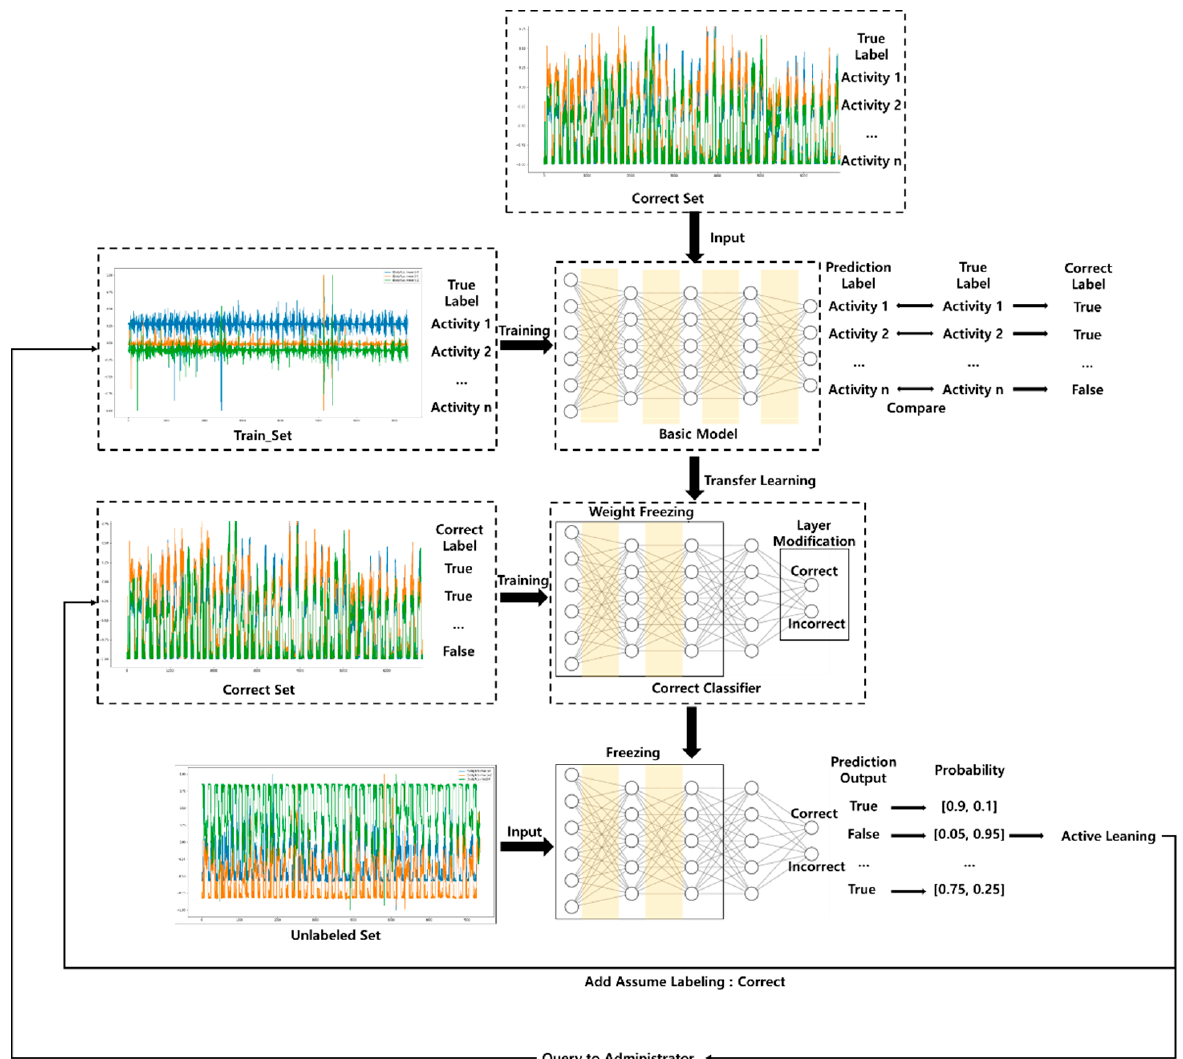
Figure 2. Active transfer learning architecture.